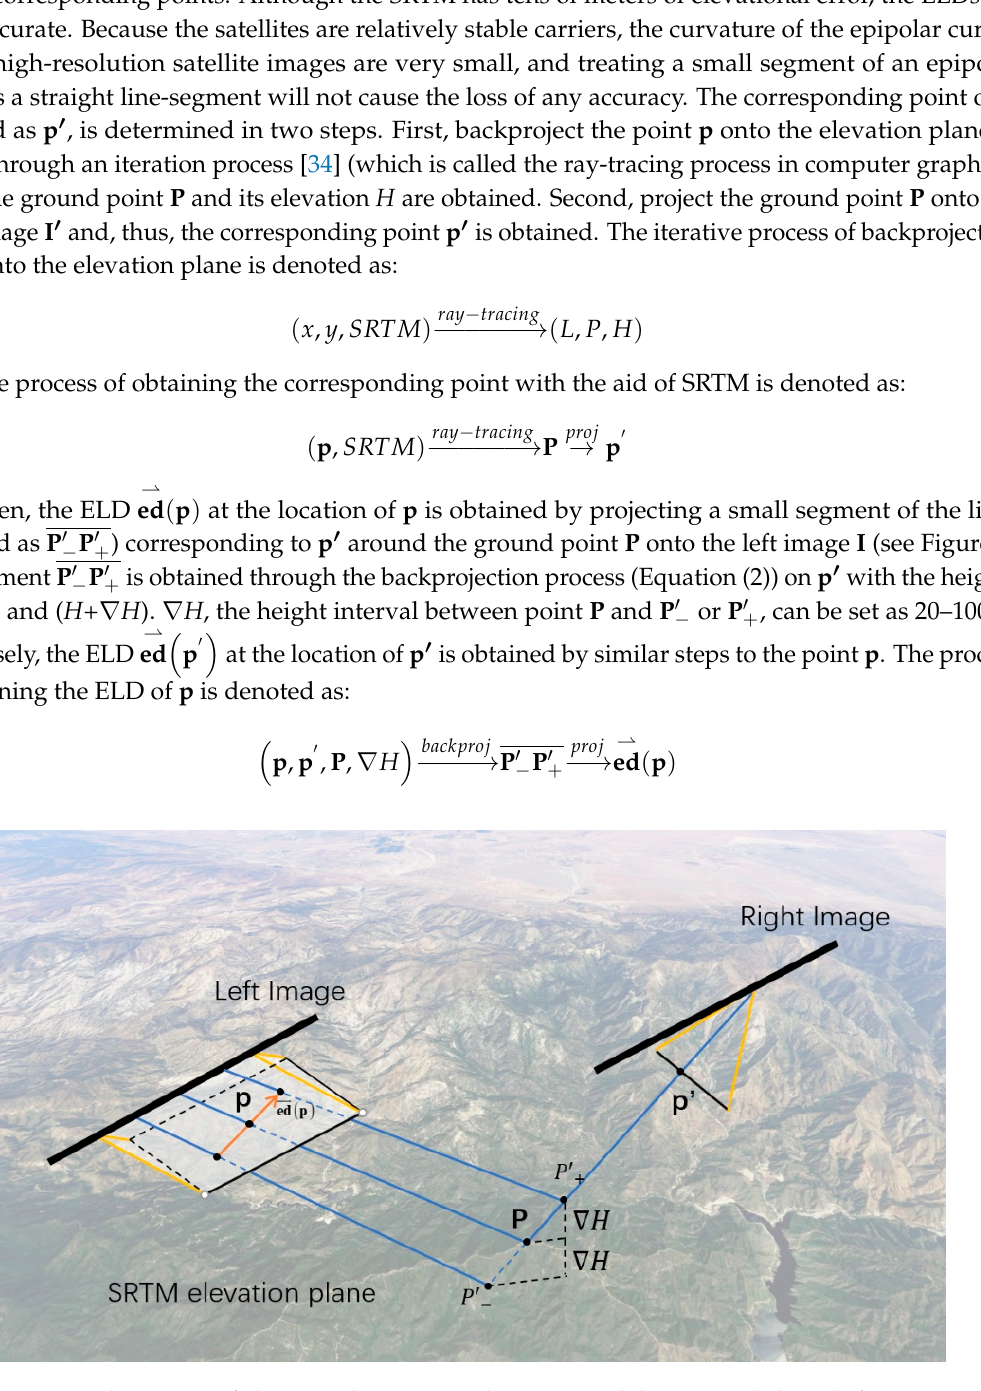
Figure 2. The process of obtaining the corresponding point and the ELD with the aid of SRTM.